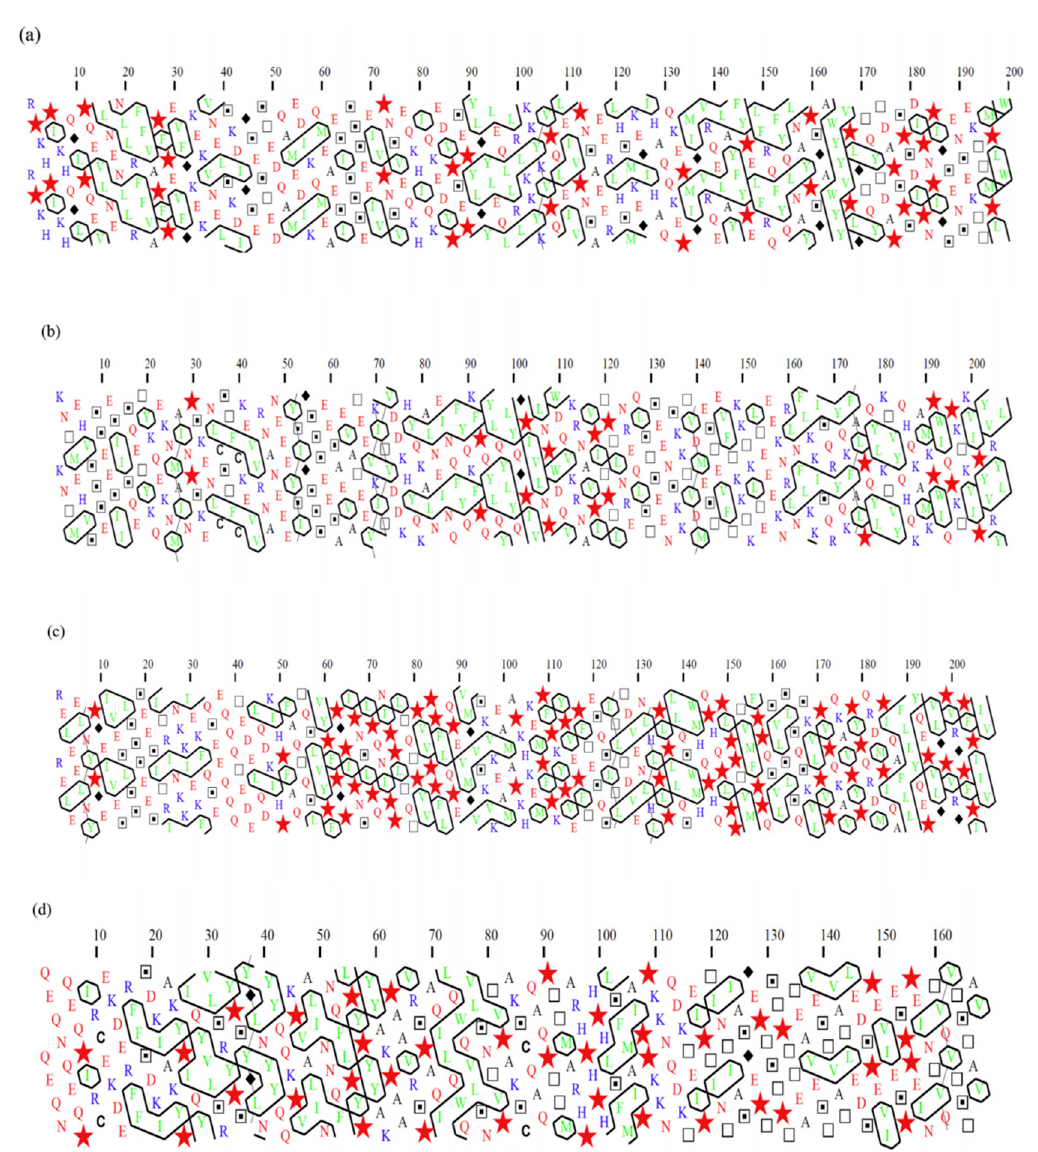
Figure 1. Hydrophobic cluster analysis (HCA) of ( a ) α s1 casein, ( b ) α s2 casein, ( c ) β casein and ( d ) κ casein, shown as 2D-HCA plots, proline has been shown by symbol star, Glycine by diamond, Serine by dotted squares and Threonine by squares. Reproduced with permission fromAdapted [Lucey, J.A.; Horne, D.S], [Perspectives on casein interactions], [Int. Dairy J], (2018).